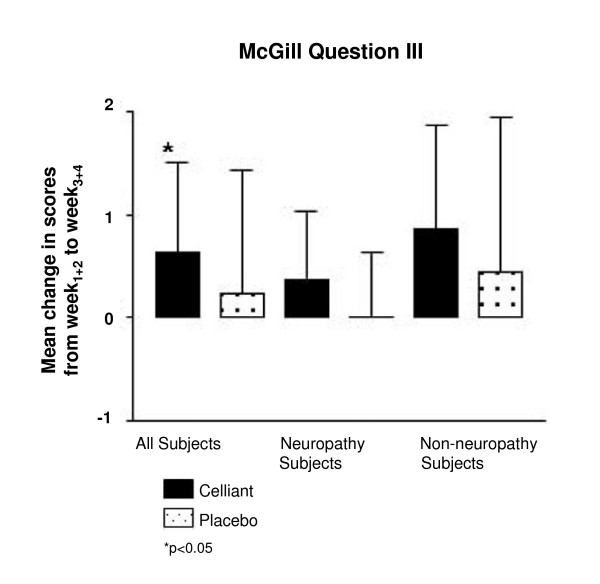
Results of McGill Question III. The difference between mean W1+2 and mean W3+4 scores is depicted. Solid bars report Celliant™ and stipled bars report control subjects. *p < 0.05.